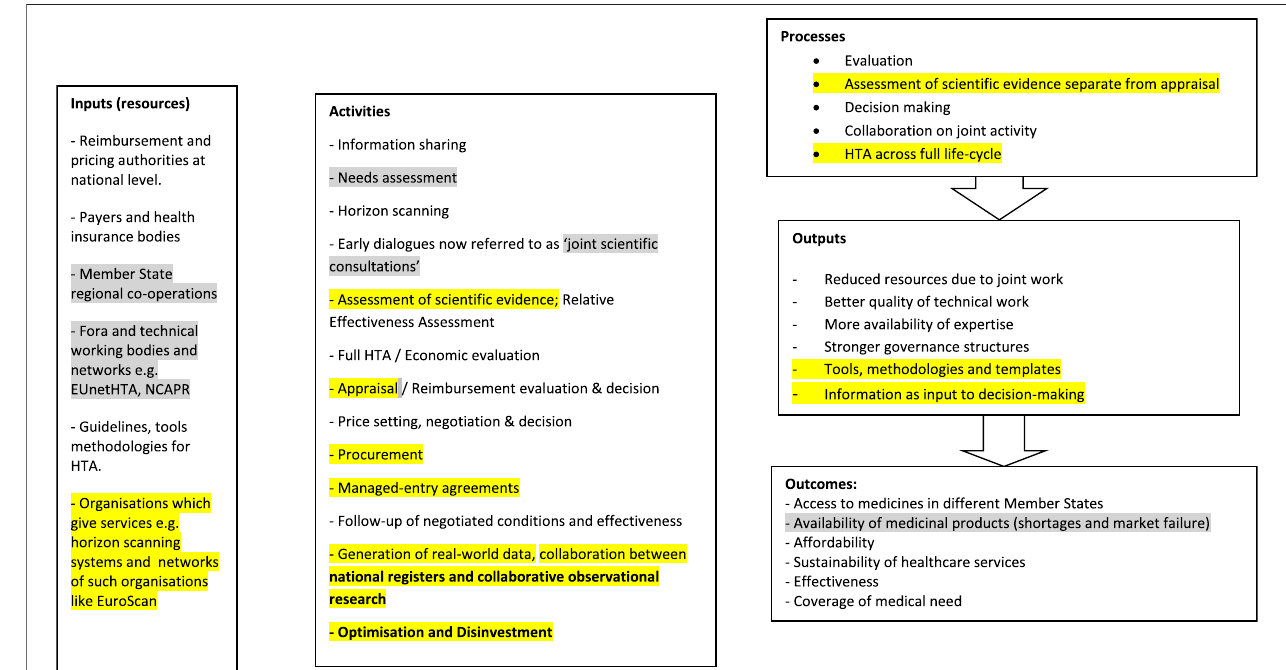
FIGURE 2 | Final Logic Model for the system of pricing and reimbursement. Grey highlights: updates from the scienti fi c literature, Yellow highlights: updates from the grey literature.